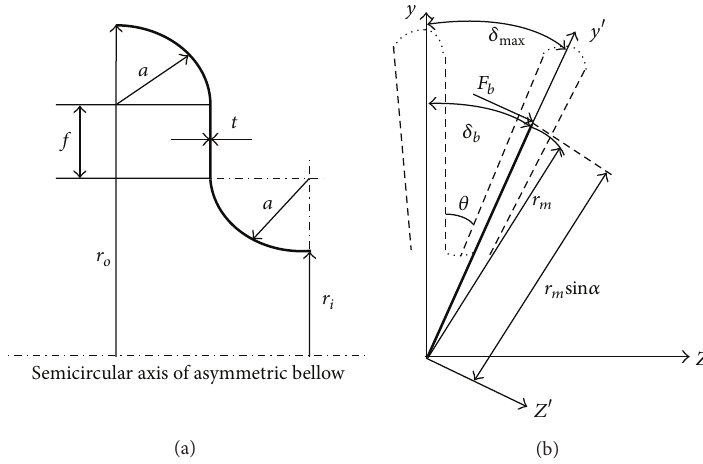
Figure 3: Geometry description of (a) one bellow convolution (b) during